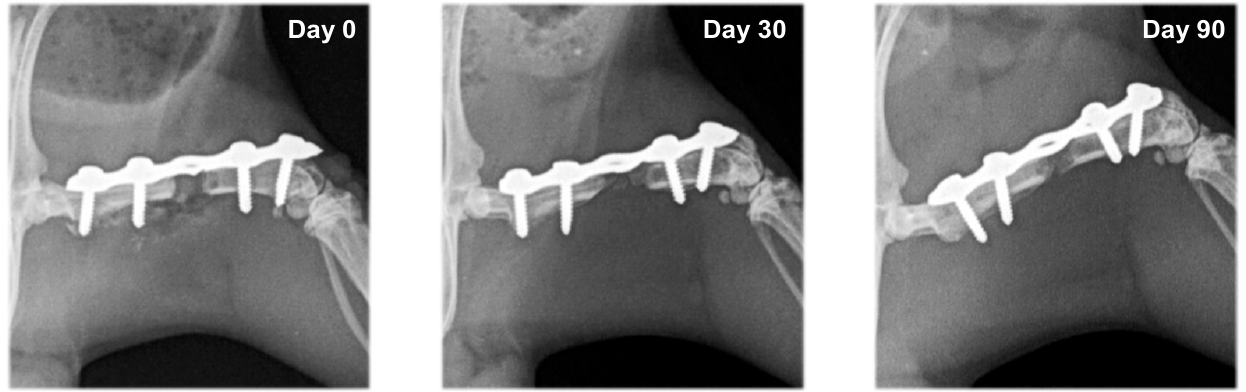
Figure 6. Serial craniocaudal radiographs of rat femurs from experimental group F4 on post-operative days 0, 30 and